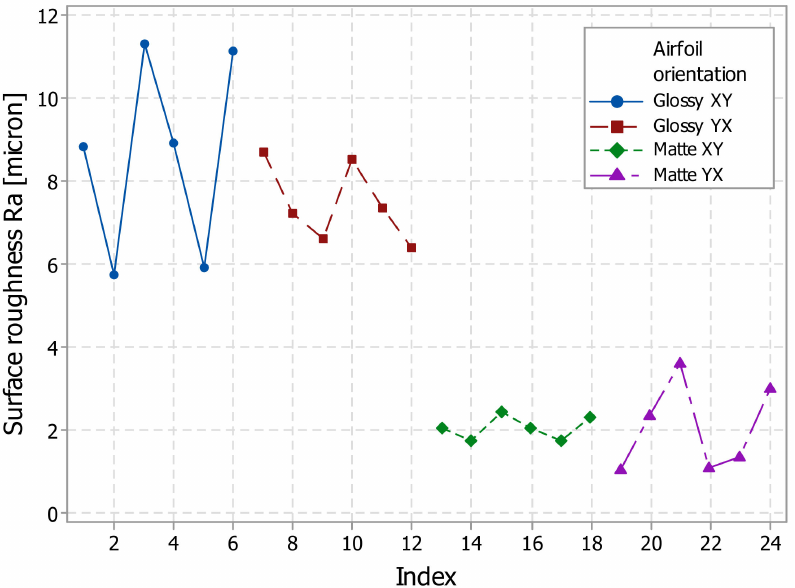
Figure 9. Surface roughness (Ra) distribution of the airfoils: glossy XY, glossy YX, matte XY, and matte